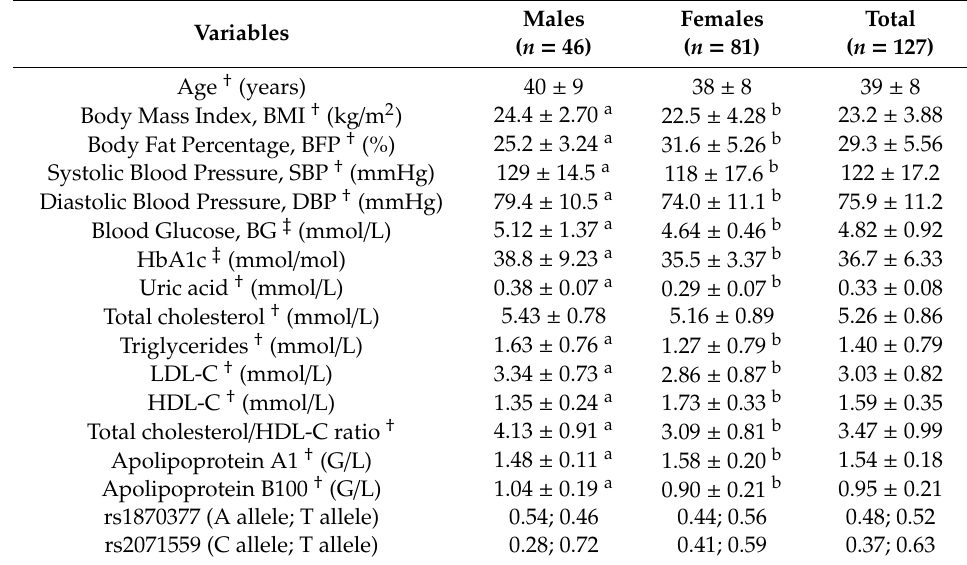
Table 1. Characteristics of the subjects.